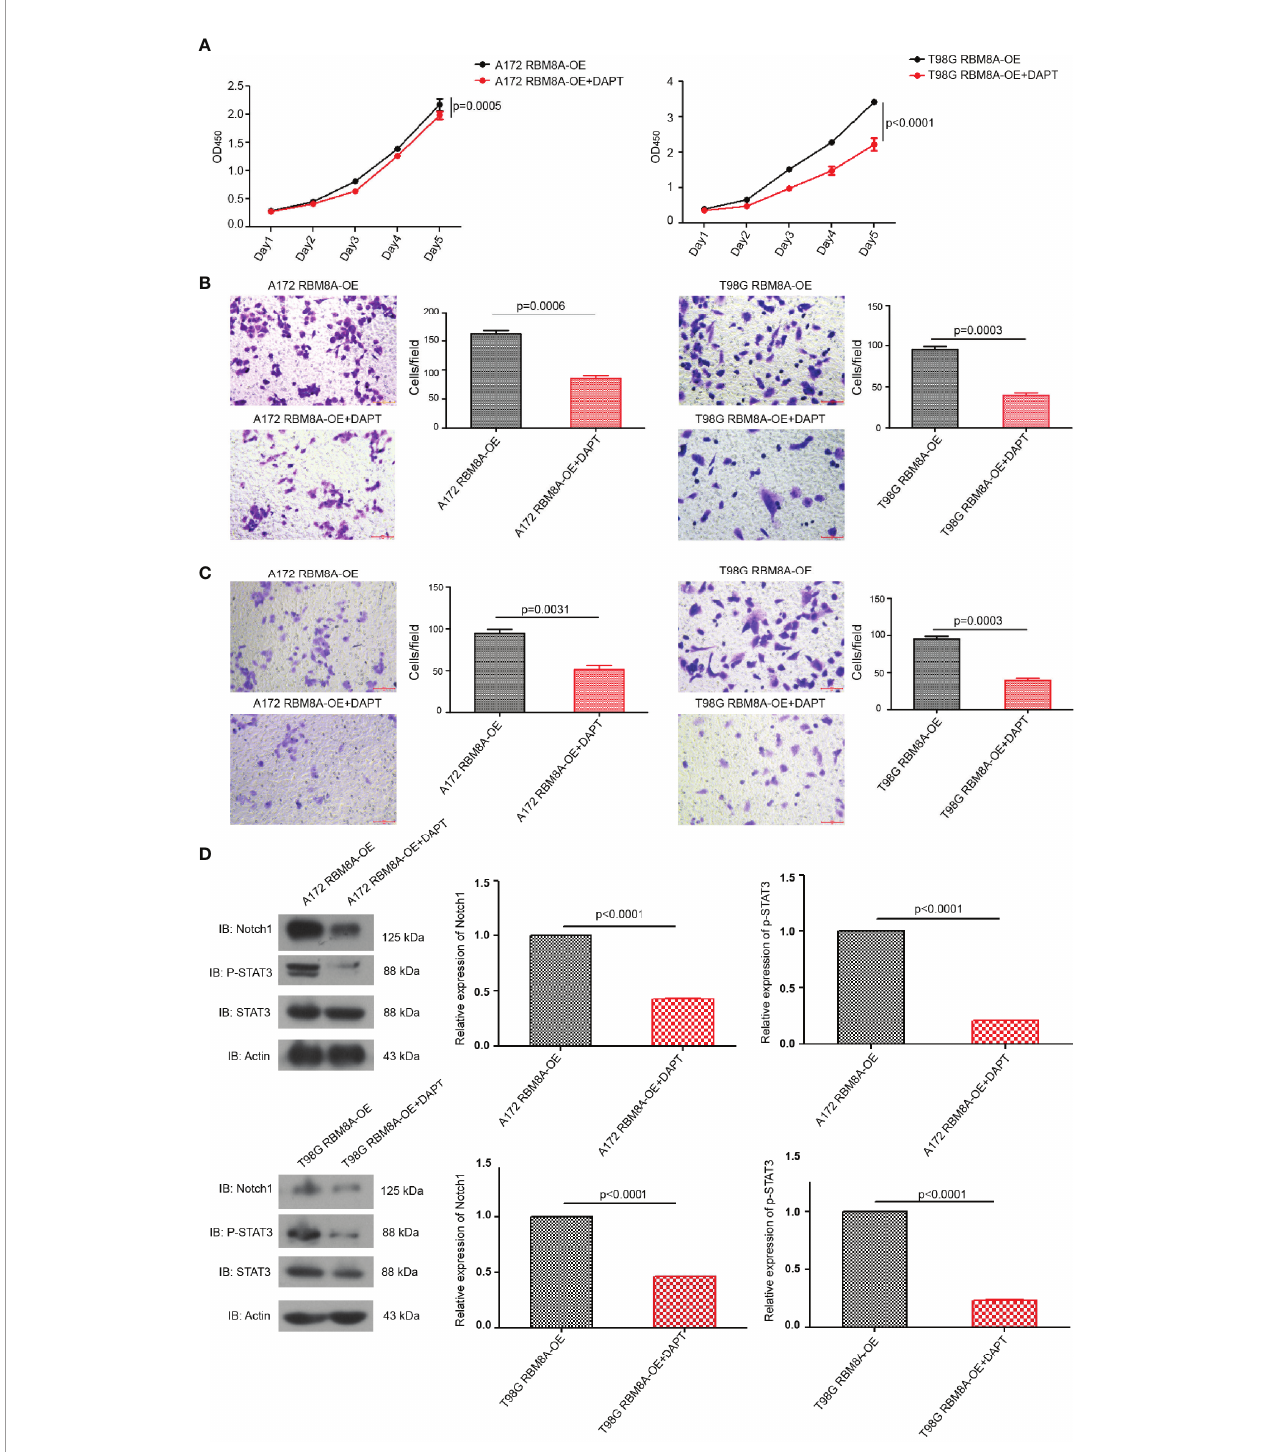
FIGURE 5 | Involvement of the Notch/STAT3 pathway in RBM8A-mediated GBM cell proliferation and invasion. (A) Cell proliferation were analyzed in A172 or T98G cells overexpressing RBM8A (OE) in the presence or absence of the g -secretase inhibitor DAPT using the CCK8 assay. (B) Transwell analysis with or without DAPT. (C) Matrigel-Transwell analysis with or without DAPT. (D) Western blot analysis of Notch1, phospho-STAT3, total STAT3, and actin after incubation with or without DAPT. All micrographs are shown at a magni fi cation of